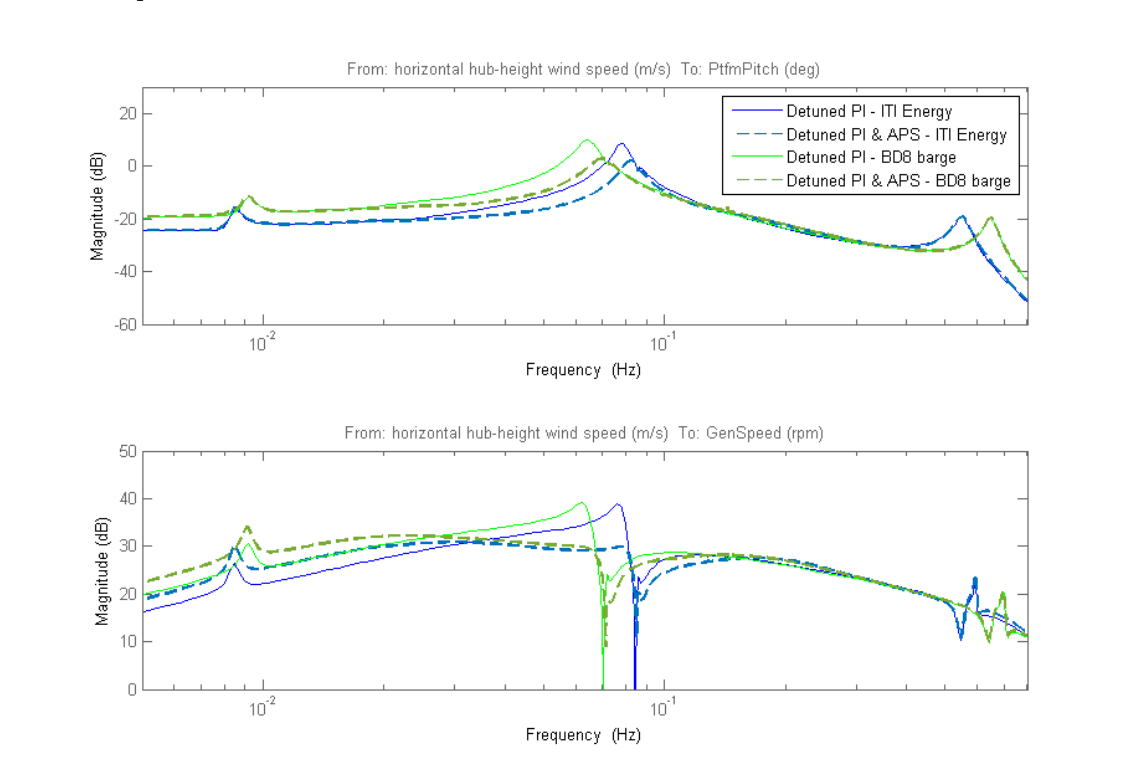
Figure 6. Closed loop bode diagrams from the wind to the platform-pitch ( top ) and from the wind to the generator speed ( bottom